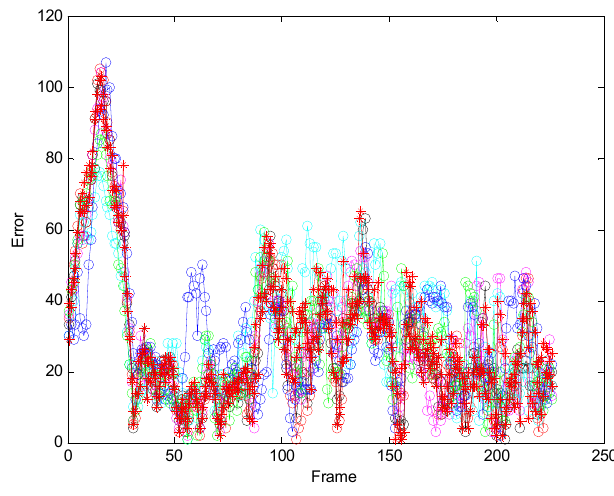
Figure 7. The analysis robustness.